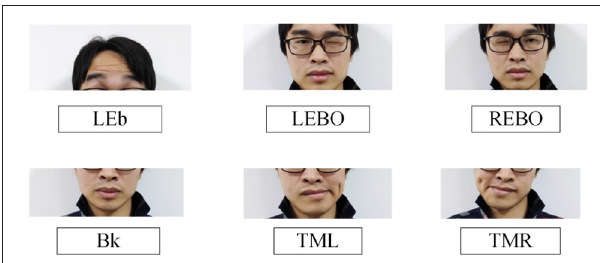
FIGURE 2 | Illustration of facial movements. From left to right and from top to bottom are Lift Eyebrows (LEb), Left Eye Blink Once (LEBO) slowly, Right